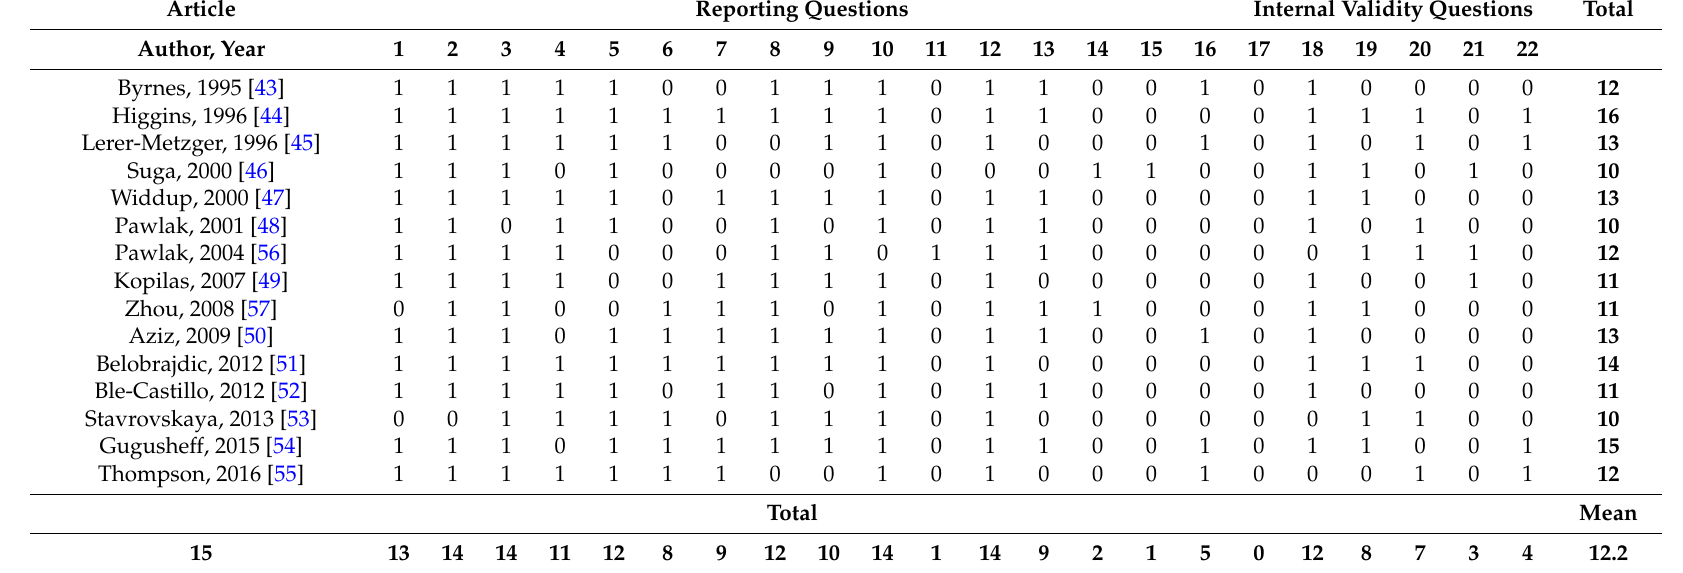
Table 7. Rat Methodological Quality Assessment; each article using rats was given a score of 0 or 1 for each question. MQA, methodological quality